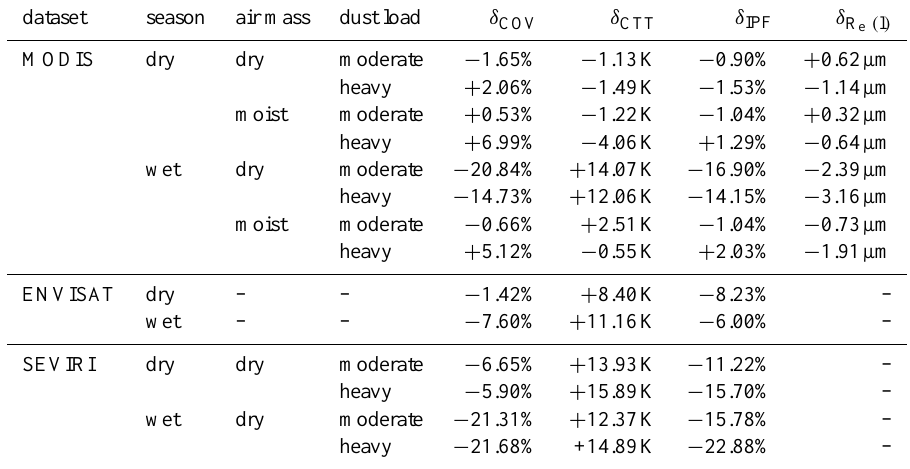
Table 2. Instantaneous change of cloud cover ( δ COV ) , cloud top temperature ( δ CTT ) , ice phase fraction ( δ IPF ) and liquid phase effective radius ( δ R , MODIS only) in the presence of dust as observed from the three different satellite datasets, separated by season (all) and e ( liquid ) air mass (MODIS and SEVIRI).